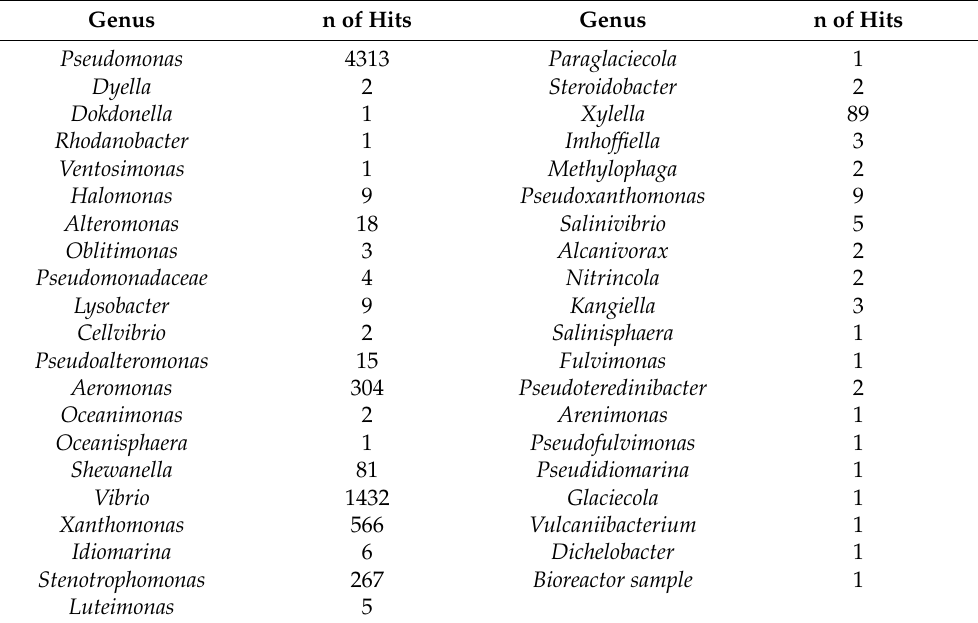
Table 2. List of bacterial genera belonging to the Gammaproteobacteria harboring the azurin-coding gene. Number of hit in each genus is reported. The “Bioreactor sample” entry has been included in the table even if it was not a genus, just for a matter of completeness. Genus n of Hits Genus n of Hits Pseudomonas 4313 Paraglaciecola 1 Dyella 2 Steroidobacter 2 Dokdonella 1 Xylella 1 Ventosimonas 1 Methylophaga Halomonas Alteromonas